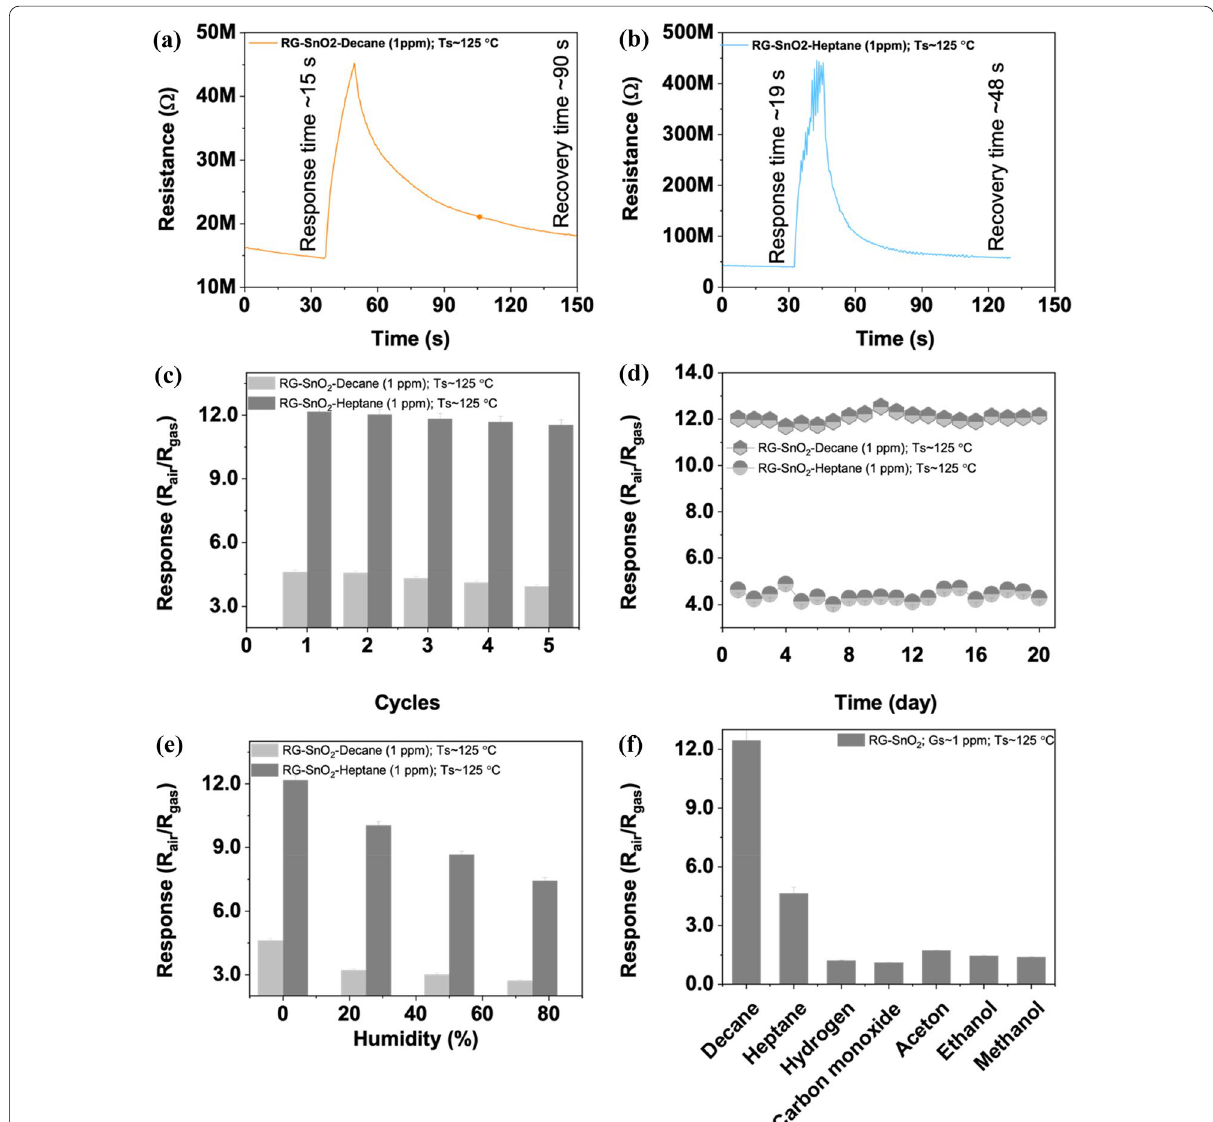
Fig. 5 a , b Response and recovery time of the sensors based on reduced graphene oxide incorporated SnO 2 nanospheres to 4 ppm of decane and decane at 125 °C. c , d Reproducibility and long‑term stability of the sensors based on reduced graphene oxide incorporated SnO 2 nanospheres to 4 ppm of decane and heptane at 125 °C. e Effect of humidity on the sensing response of the sensors based on reduced graphene oxide incorporated SnO 2 nanospheres to 4 ppm of decane and heptane at 125 °C to 5 ppm. Selectivity of the fabricated sensor toward different target gas such as heptane, decane, hydrogen, carbon monoxide, acetone, ethanol, and